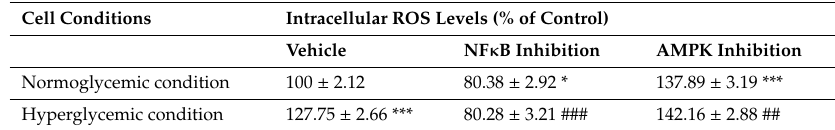
Table 4. E ff ect of nuclear factor kappa B (NF κ B) and AMP-activated protein kinase (AMPK) inhibition on intracellular ROS levels of cerebral endothelial cells during hyperglycemic condition.